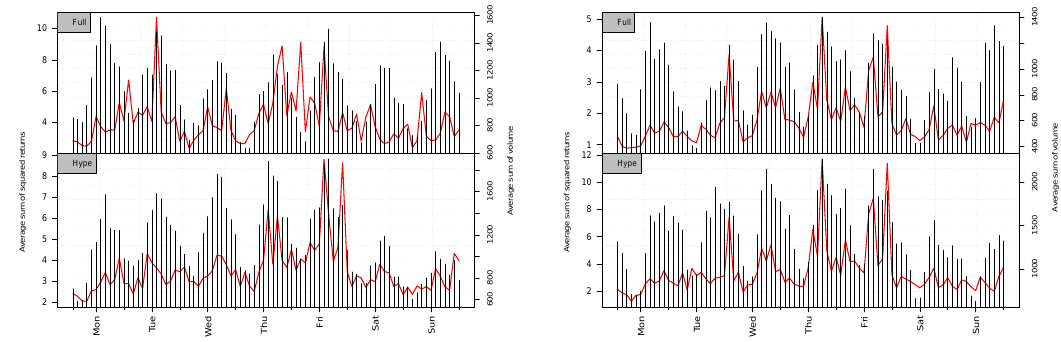
Figure 5. Weekly seasonality computed for the Bitstamp (left figures) and Coinbase (right figures) exchanges over the full sample and Hype period. Red lines report the average realized volatility ( left axis ) while the vertical bars report the average sum of volume ( right axis